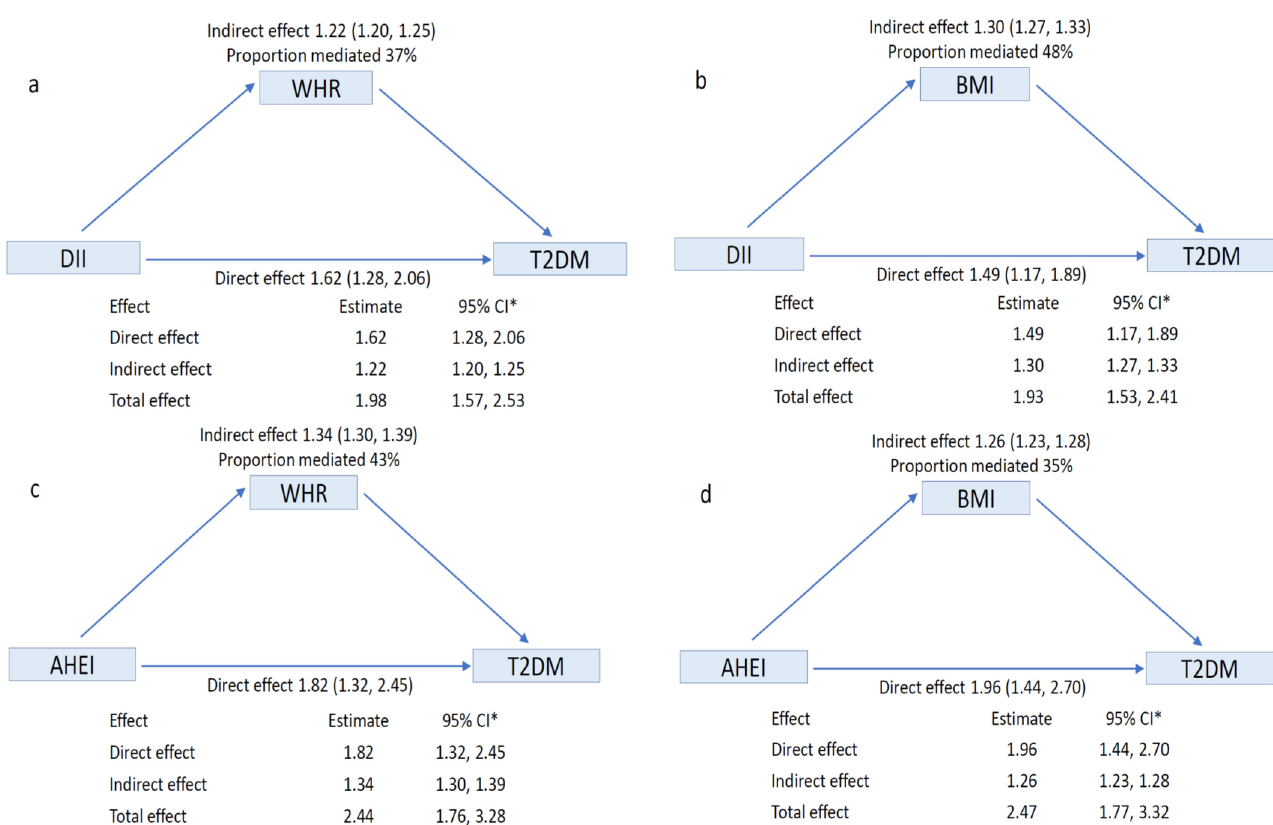
Figure 2. Mediation analyses of the association dietary pattern with risk of T2DM ( a ) DV—DII, IV—T2DM, MV—WHR. ( b ) DV—DII, IV—T2DM, MV—BMI. ( c ) DV—AHEI, IV—T2DM, MV—WHR ( d ) DV—AHEI, IV—T2DM, MV—BMI. Covariates for all mediation models—age, sex, socio-economic status, family history of T2DM, smoking status, alcohol intake and level of physical activity. Poisson regression model for direct effect model, linear regression for mediator model were fitted. The bias corrected 95% CI of the estimates were computed using the bootstrap resampling method with 1000 replications. * Statistically significant for p <0.001.